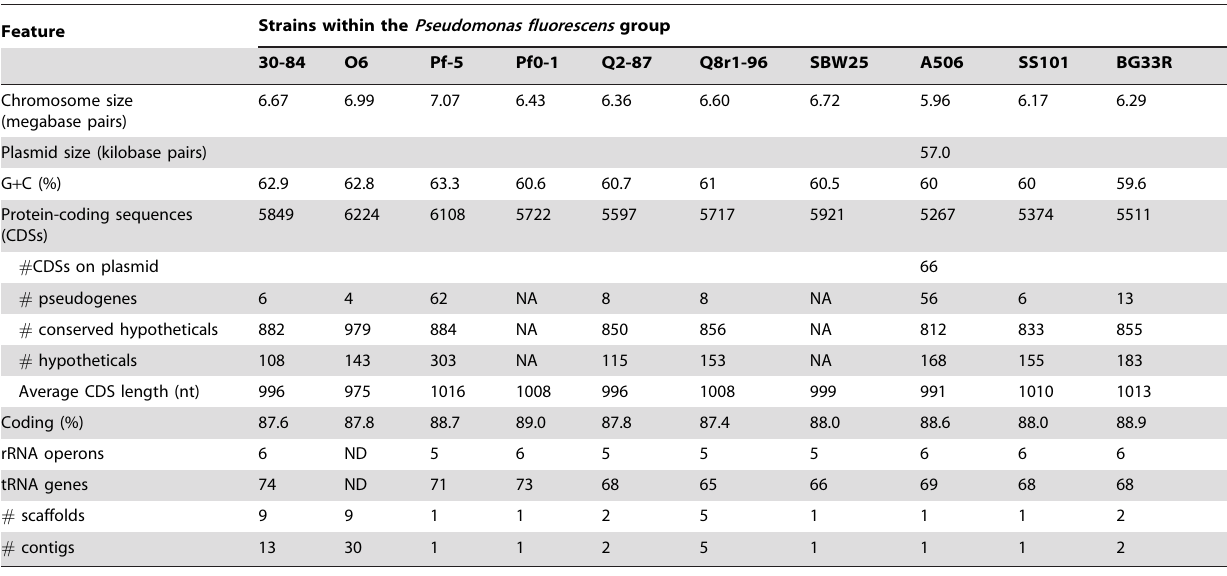
Table 2. Genomic